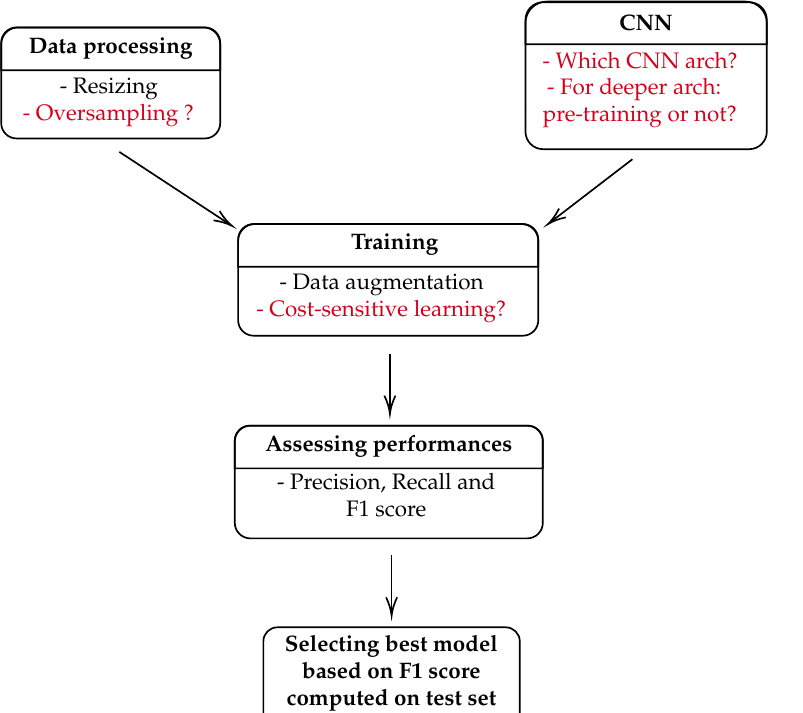
Figure 5. Workflow for this study. Items inside the boxes that are highlighted in red represent the choices tested in this study, whereas the items in black are the methods applied in every